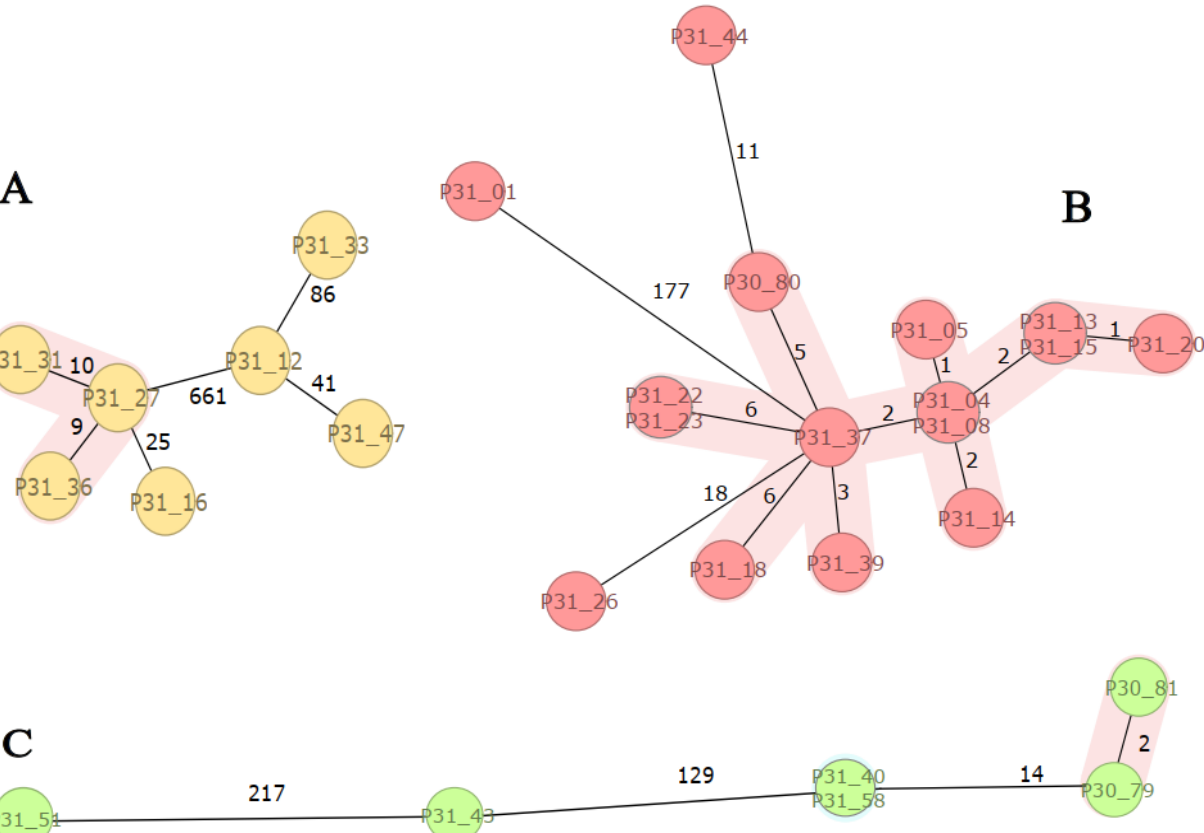
Figure 1. SeqSphere analysis of E. coli high-risk clones: ST131, ST410, and ST617. Figure Legend: Minimum spanning three based on cgMLST analysis of ESBL-producing E. coli ST131 (( A ); n = 7), ST410 (( B ); n = 16), and ST617 (( C ); n = 6) isolates. The isolates are coloured by sequence type (ST) and numbered according to Supplementary Table S1. Clusters are coloured in pink and related to the cluster distance threshold of ≤ 10 allele differences as given in numbers along the lines between individual isolates.